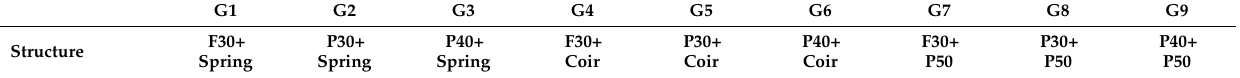
Table 1. Mattress structure configurations of different mattress groups.